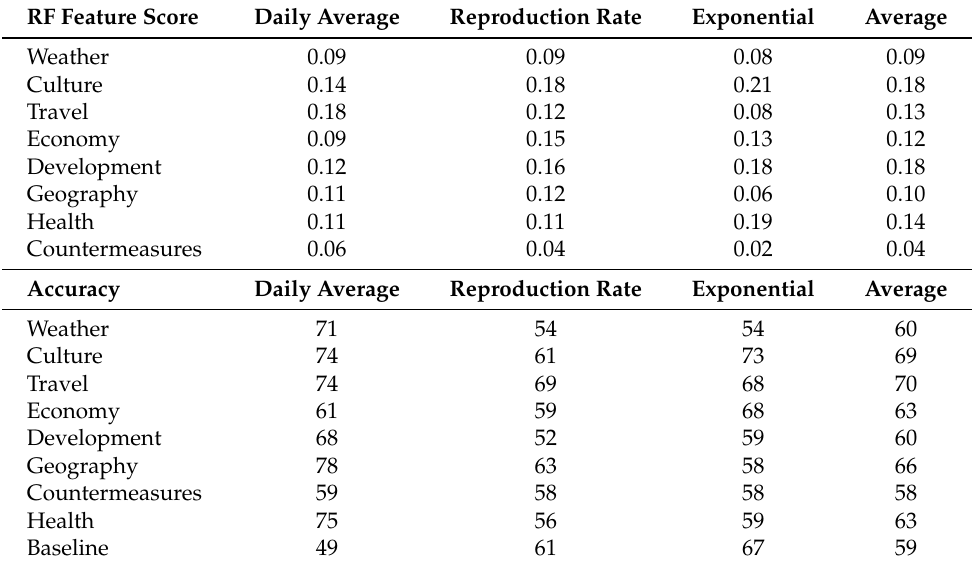
Table 8. Top : Aggregate feature ranking using RF feature score. These values are normalized so that they sum to 1. Bottom : Accuracy (%) when using only one feature category when training and testing the classifier.